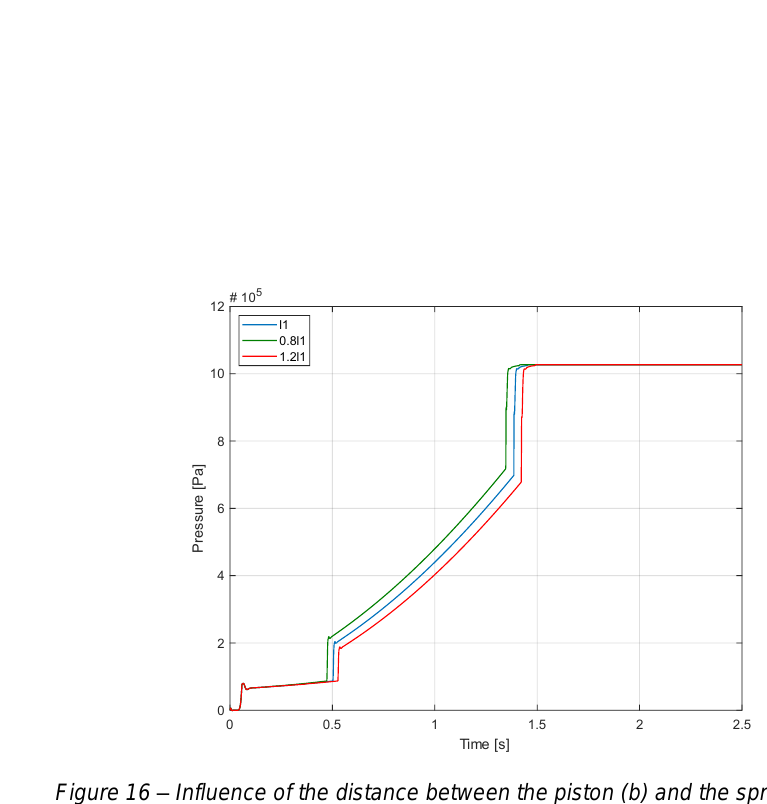
Figure 16 – Influence of the distance between the piston (b) and the spring (i) on the pressure modulation